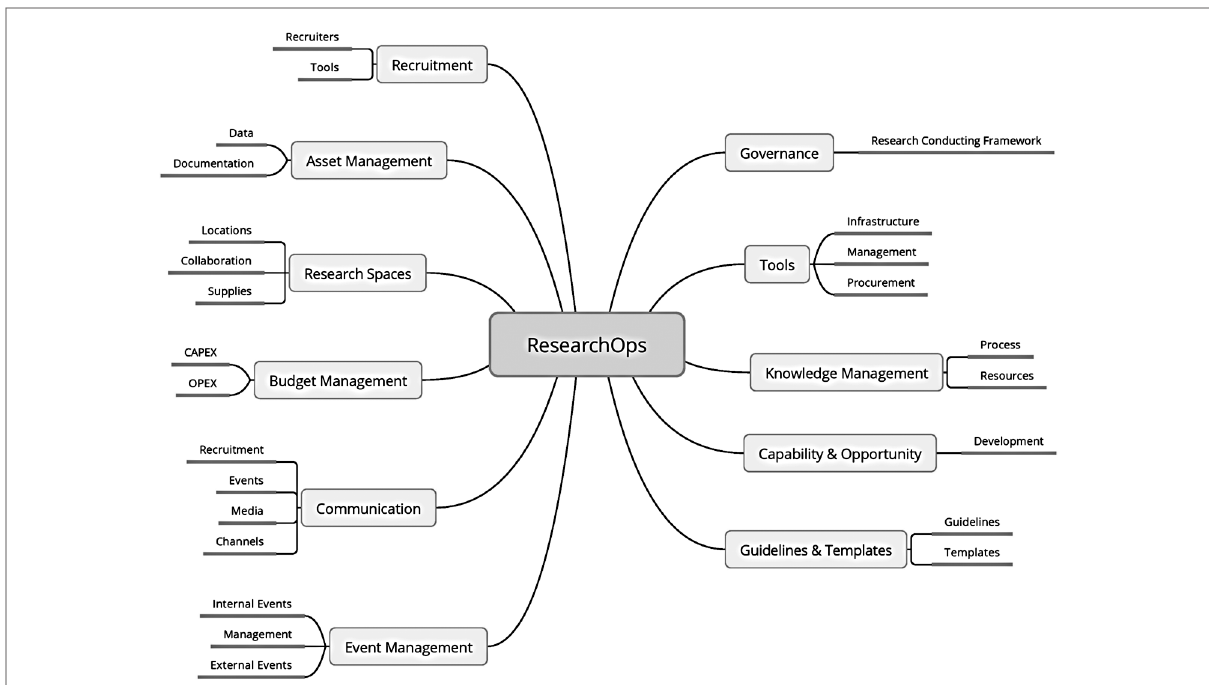
FIGURE 3 ResearchOps Community-separated resources for each of the topics. The link to community- made tools that support each aspect of these open topics can be found in the footnote below.